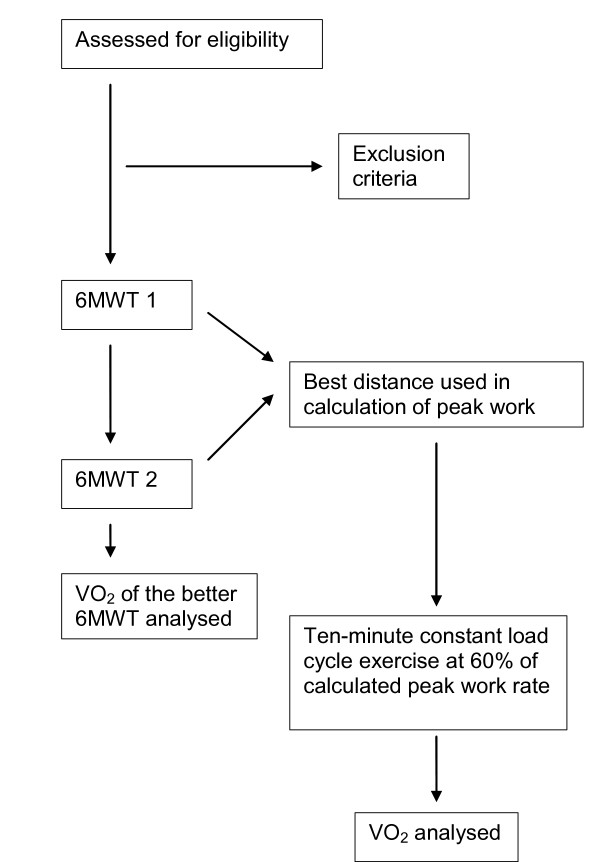
Research design.